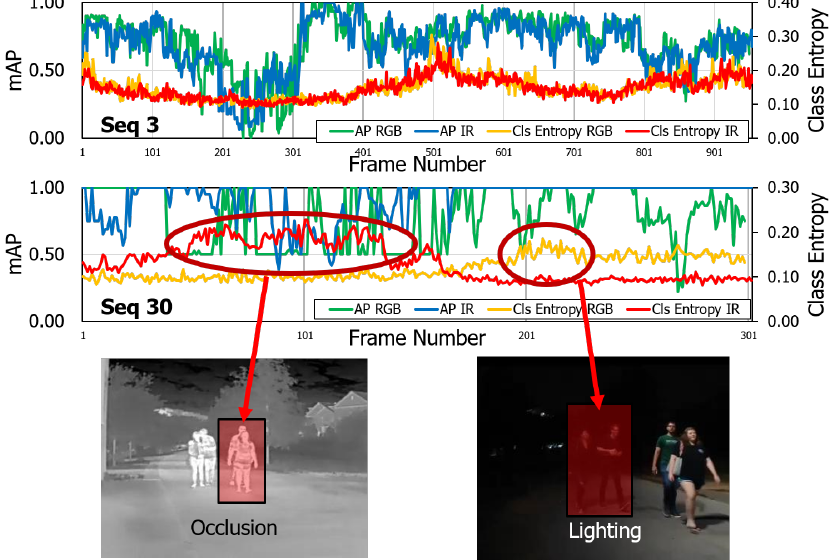
Figure 10. Per-sequence Model Uncertainty Comparison on the CAMEL Test Set. Seq03 is well-lit, so no major fluctuations in uncertainty are observed. In Seq 30, two major spikes are observed in RGB and IR domains due to occlusion and lighting, respectively. Reprinted with permission from ref.